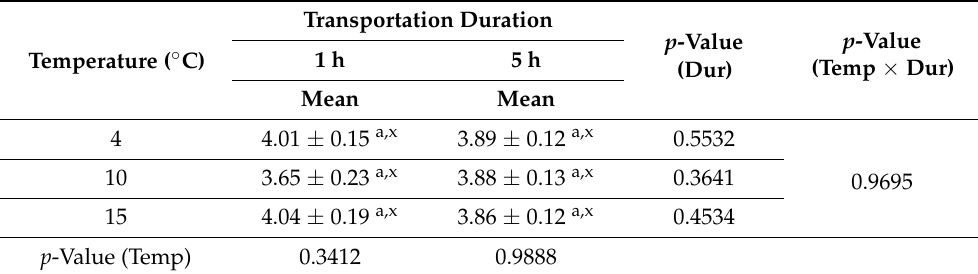
Table 2. Effects of transportation temperatures (4 ◦ C, 10 ◦ C, and 15 ◦ C) for two different transportation durations (1 and 5 h) on cooking loss (%) of pectoralis major muscles in broiler chickens.